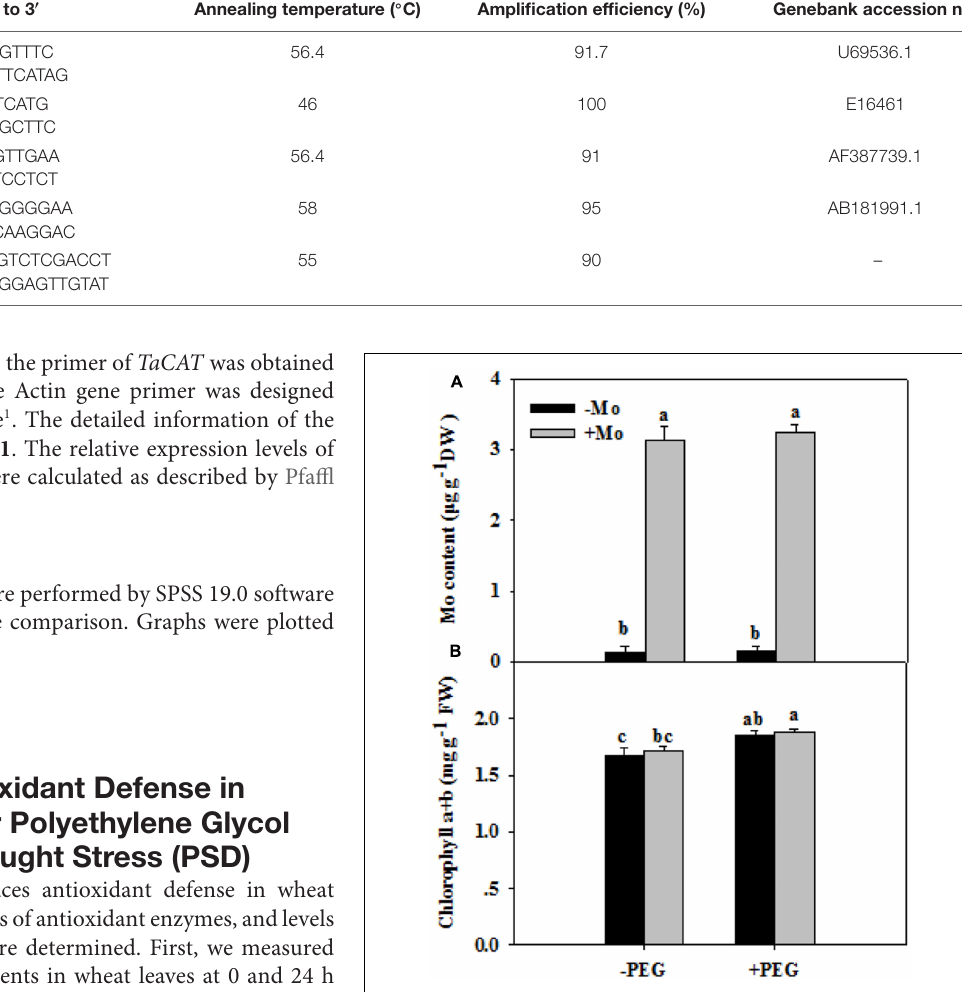
TABLE 1 | Sequences of primers used for RT-PCR. Genes Primer sequence 5 (cid:48) to 3 (cid:48) Annealing temperature ( ◦ C)